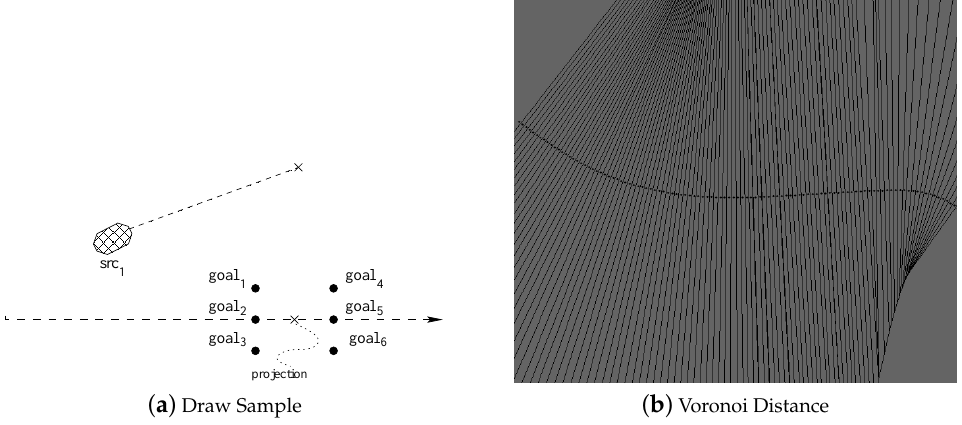
Figure 6. ( a ) shows an example of how procedure D RAW S AMPLE K ERNEL generates the goal samples already analyzed in Figure 5. The Voronoi map ( b ) shows all points with the minimum distance for any point along the desired reference path (i.e., the points on the normals to the path itself). Notice that as the planner is running over and over again to compute paths in close proximity of one another, orthogonal projections must be computed and recomputed for many points close to the vehicle. To avoid those re-computations and to make D RAW S AMPLE K ERNEL more time efficient, all orthogonal projections for dense points around the vehicle are computed during the map generation for all maps points at fixed time intervals. This is allowed by a proper use of Vonoroi maps. Figure 6b is a logical representation of the Voronoi map, where for each point p , the segment passing from p and orthogonal to the path identifies the point on the path closest to p . Each Voronoi map is stored into a texture of size equal to ( 1000 × 1000 ) pixels. Within the Voronoi map, each pixel is represented with 4 float values stored as an RGBA information. The first float indicates the index of the orthogonal projection path point stored within the texture path. All other float values store the angle of the tangent to the path and its orthogonal direction. These data are used by the kernel to compute the goals. Each map includes the GPS coordinates stored within the first top-left pixel. This pixel also specifies the pixel density within the map, i.e., the real distance between two points. This density is a function of the vehicle speed at the moment the map is generated by the global planner. Each thread reads this information and it is then able to compute the lookahead position on the map. Please note that as each map may serve several path planning cycles, it has to be large enough to include all lookahead positions computed within the next few